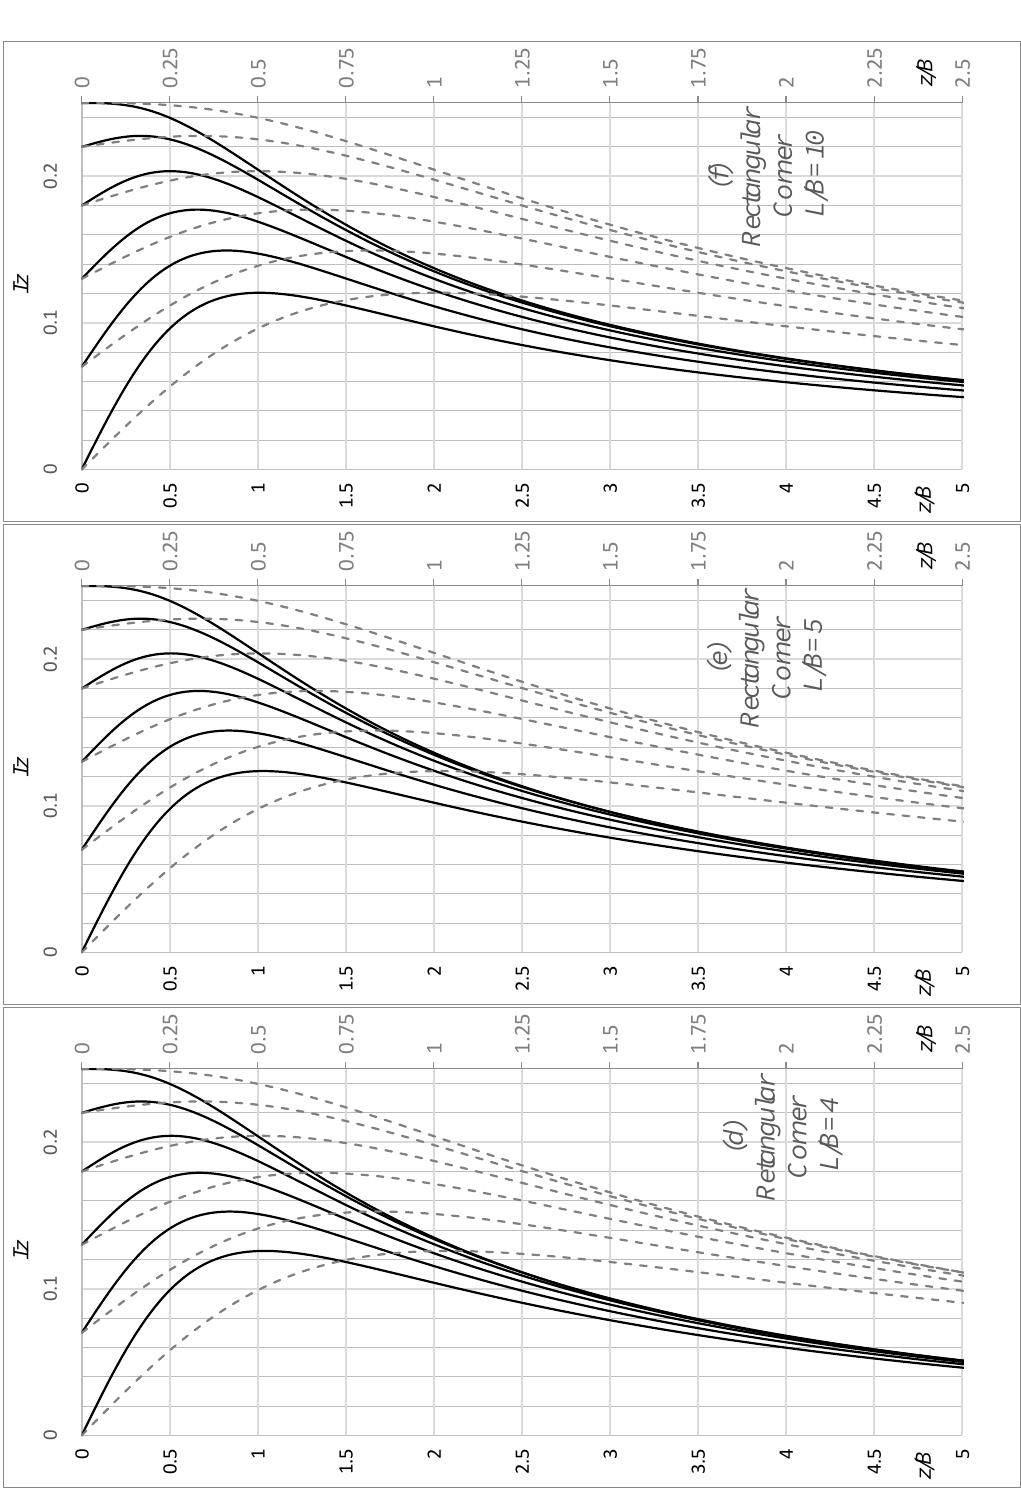
Figure 4. I z versus normalized depth charts referring to the corner of flexible rectangular footings for various ν values; ν ranges from 0.5 to 0 (left to right) with 0.1 interval.